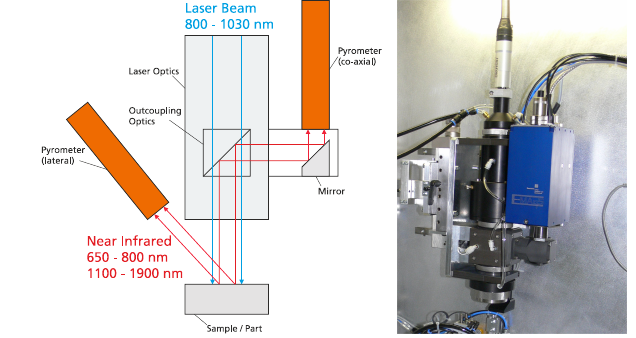
Figure 1. Left: schematic diagram – variants of assembling a tem- perature measurement device for laser heat treatment. Right: ex- ample of the thermal imaging system E-MAqS mounted on special ring optics for co-axial temperature measurement in industrial mass production of valves.